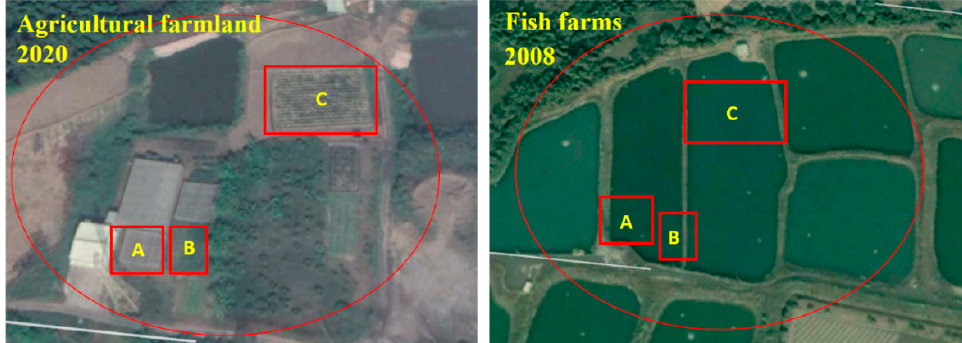
Figure 9. Historical land use image comparison of first three farms (A, B, and C) in this study (Google Earth Pro 7.3.3.7786 (2021)) .